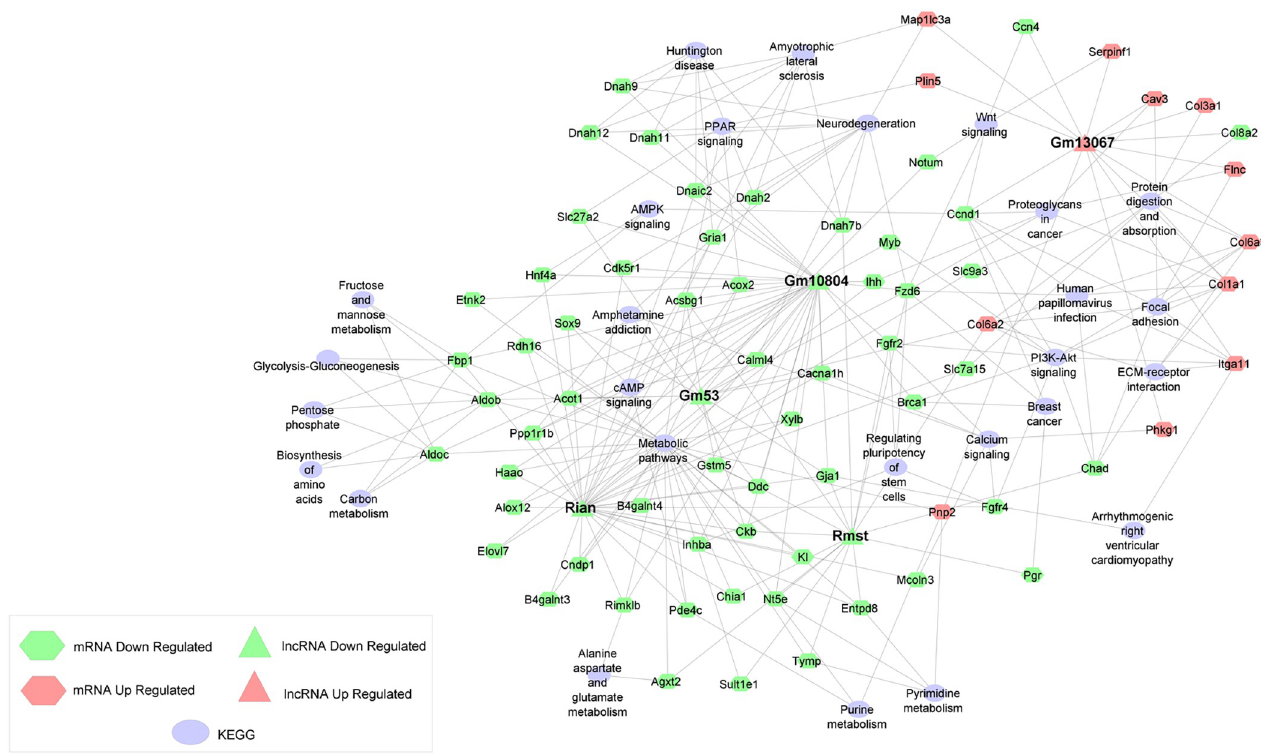
Fig 4. Network analysis of the top 5 network analysis of the top 5 lncRNAs based on the number of interactions with mRNAs. Hexagons represent mRNAs, and triangles represent lncRNAs. Light blue nodes represent KEGG pathways. Expression of lncRNA and mRNA are represented according to the colors red and green, corresponding to up and down-regulated transcripts, respectively.